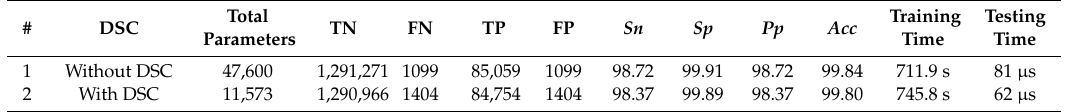
Table 3. E ff ect of DSC implementation on CNN layers